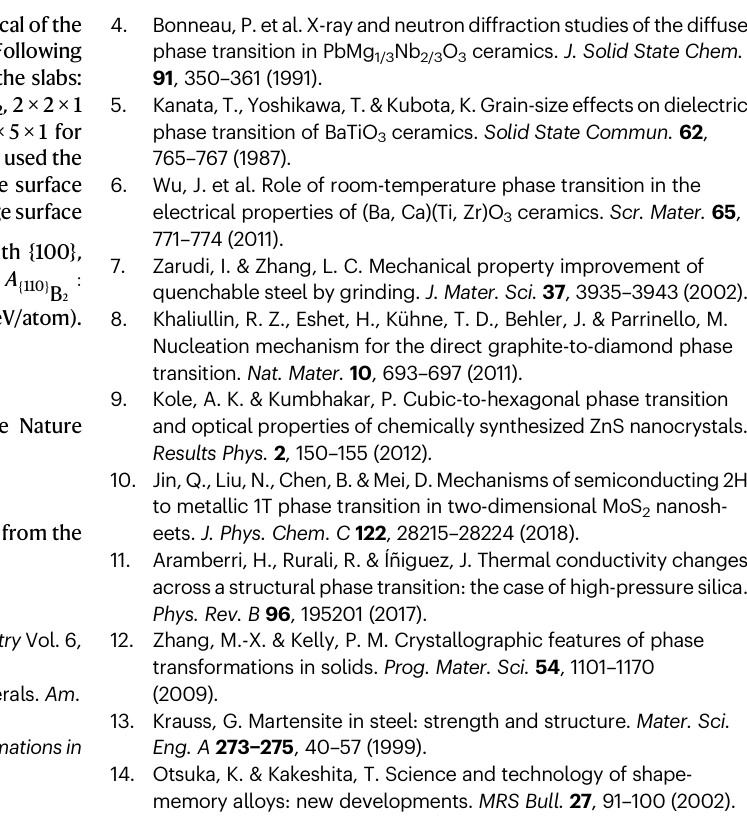
Fig. 5 | Nucleation of B2 phase in an fcc crystal. a TEM and FFT images (from the dashed yellow and white boxes) showing the nucleation of a B2 phase ( t − t 0 =167s) on the top left corner surface of an fcc PdCu NP ( t − t 0 =12s). b Sequenceof inverseFFTimagesof thearea(dashed yellowbox)in a showingthe nucleation( t − t 0 =12 – 73s)andgrowth( t − t 0 =167s)oftheB2phase(Supplementary Movie6).(seeSupplementaryFig.9afortheunprocessedTEMimages).Thefcc,B2, and interface regions are false-colored in red, blue, and orange, respectively. Note